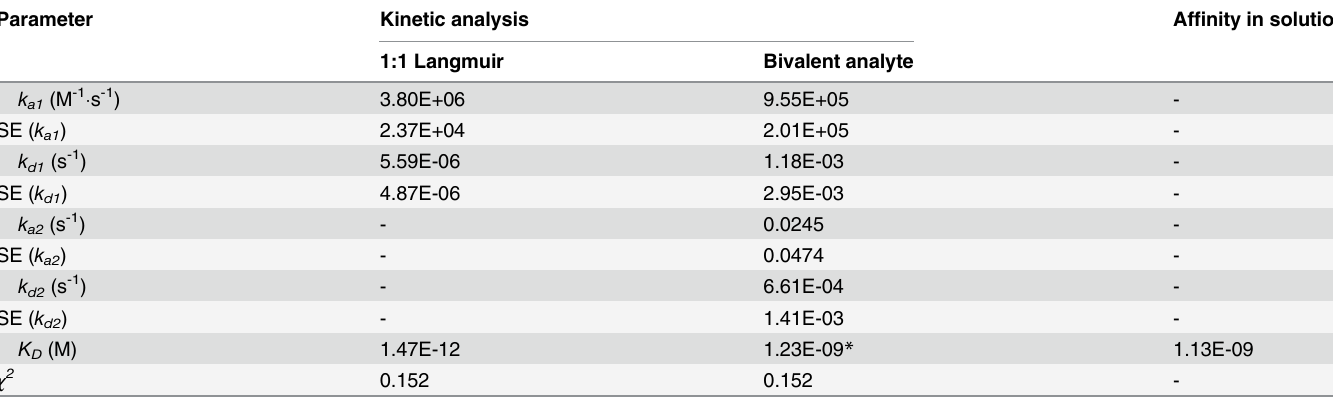
Table 2. Kinetic and affinity constants for 15-I-C5.